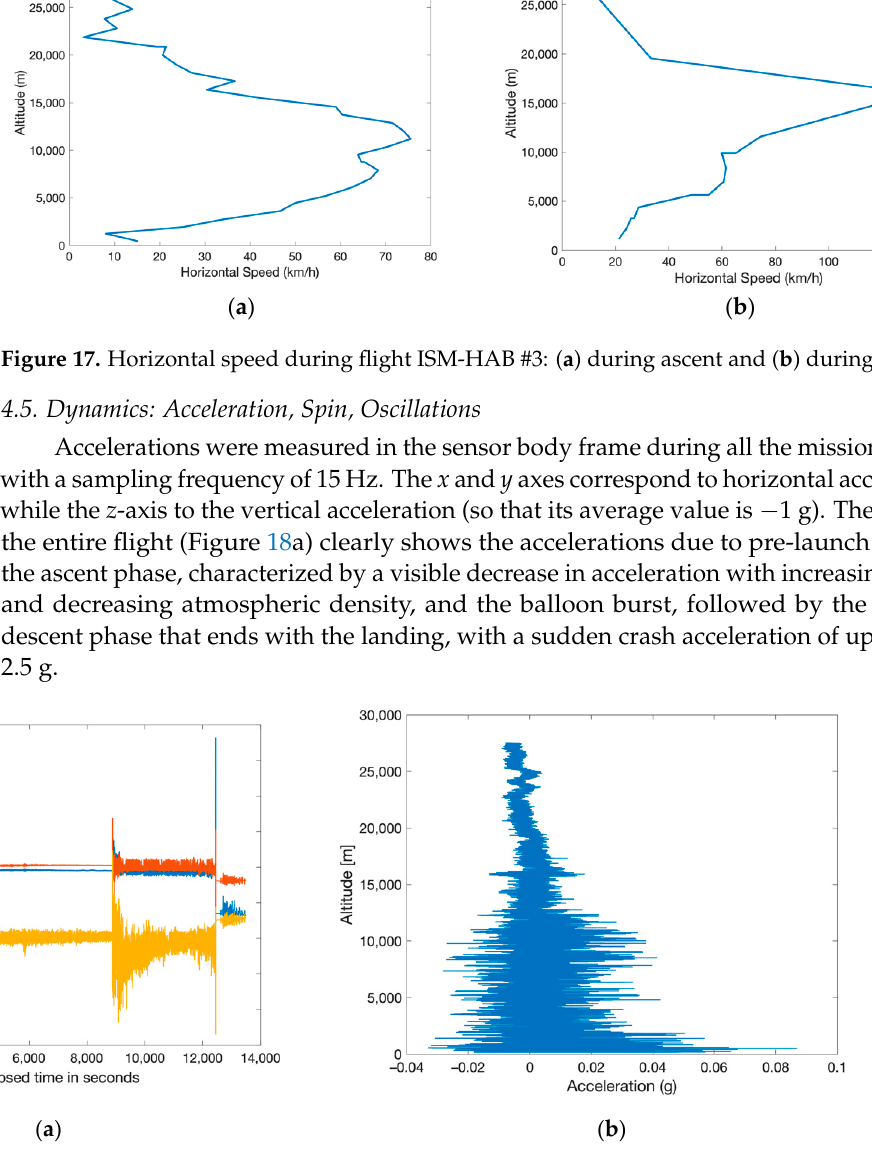
Figure 18. Gondola dynamics: ( a ) acceleration along the three body axes during the whole flight, and ( b ) acceleration along the x -axis as a function of altitude.